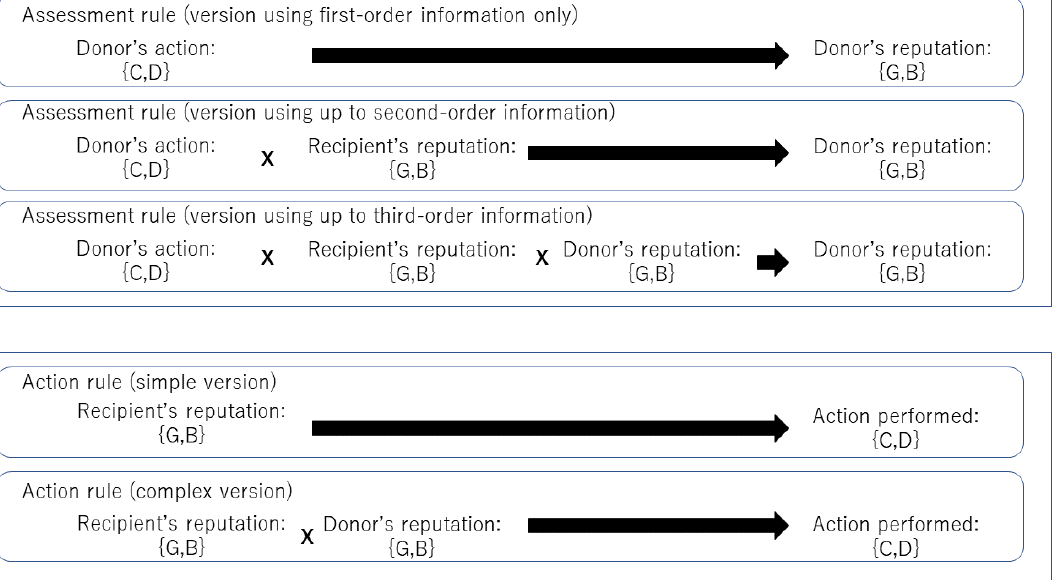
Figure 3. Assessment and action rules for binary reputation labeling. (G: “Good label”; B: “Bad label”; C: “Cooperation”; D: